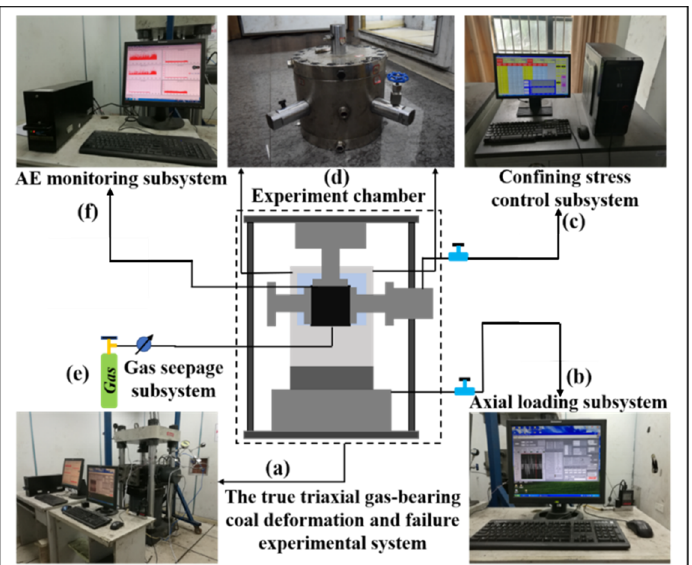
Figure 1. Schematic diagram of the experimental system. ( a ) The true triaxial gas-bearing coal deformation and failure experimental system; ( b ) axial loading subsystem; ( c ) confining stress control subsystem; ( d ) experiment chamber; ( e ) gas seepage subsystem; ( f ) AE monitoring subsystem.